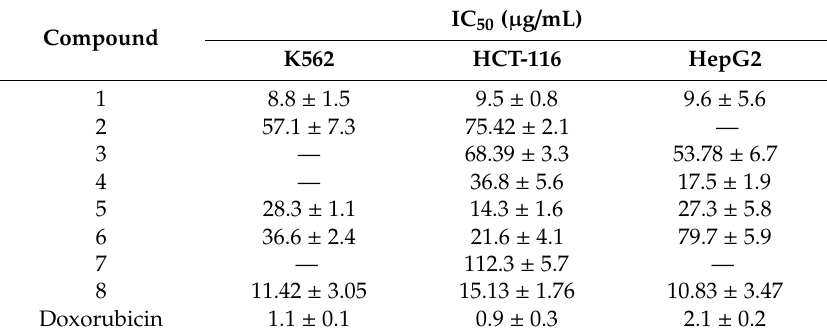
Table 3. The cytotoxicity of compounds 1–8.